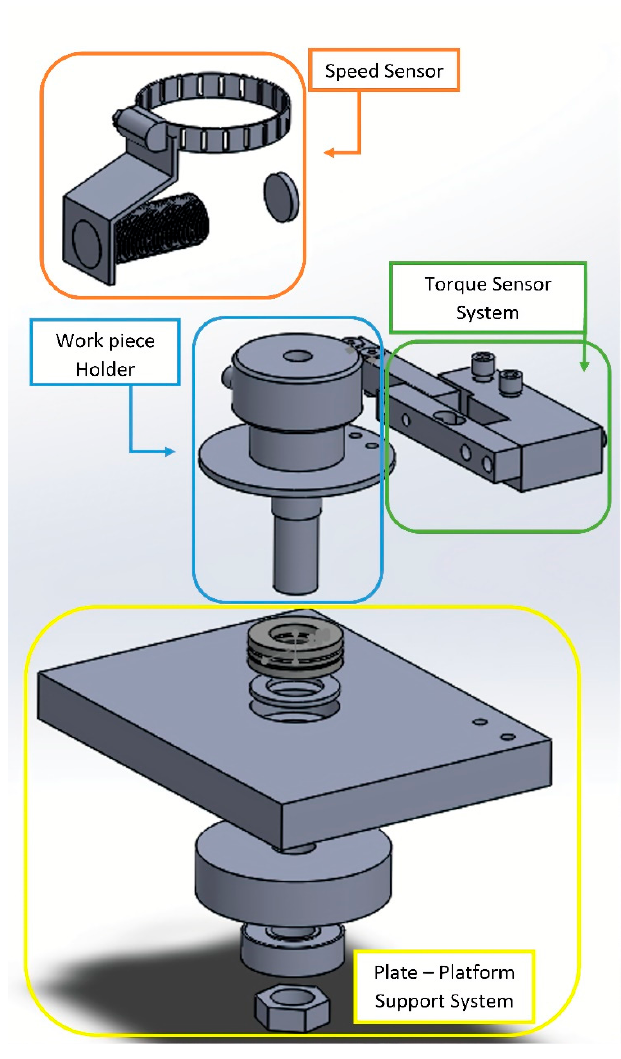
Figure 6. Final assembly.